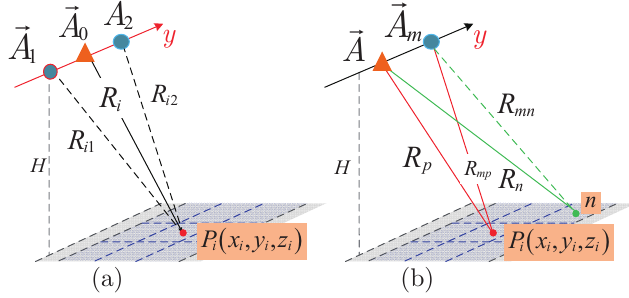
Figure 3. Monostatic SAR case: ( a ) diagram of subaperture summation; ( b ) diagram of error